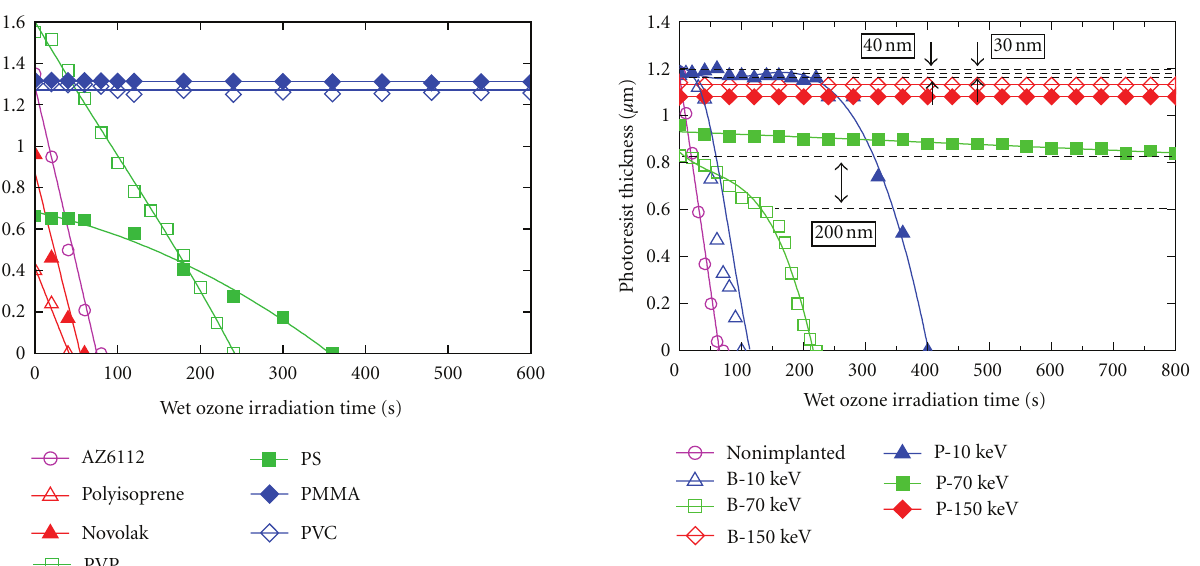
Figure 4: Removal of B and P ion-implanted resists with various acceleration energies using wet